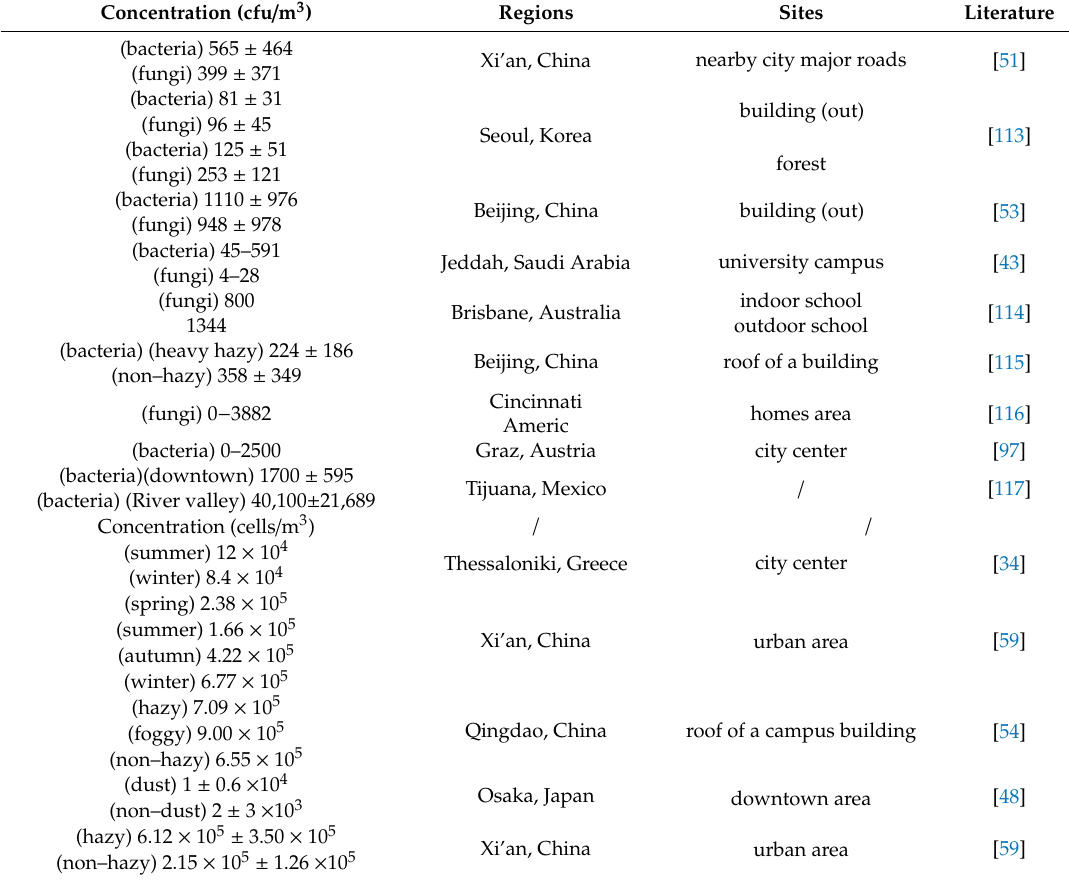
Table 4. Concentration of bacteria and fungi in di ff erent regions and weather